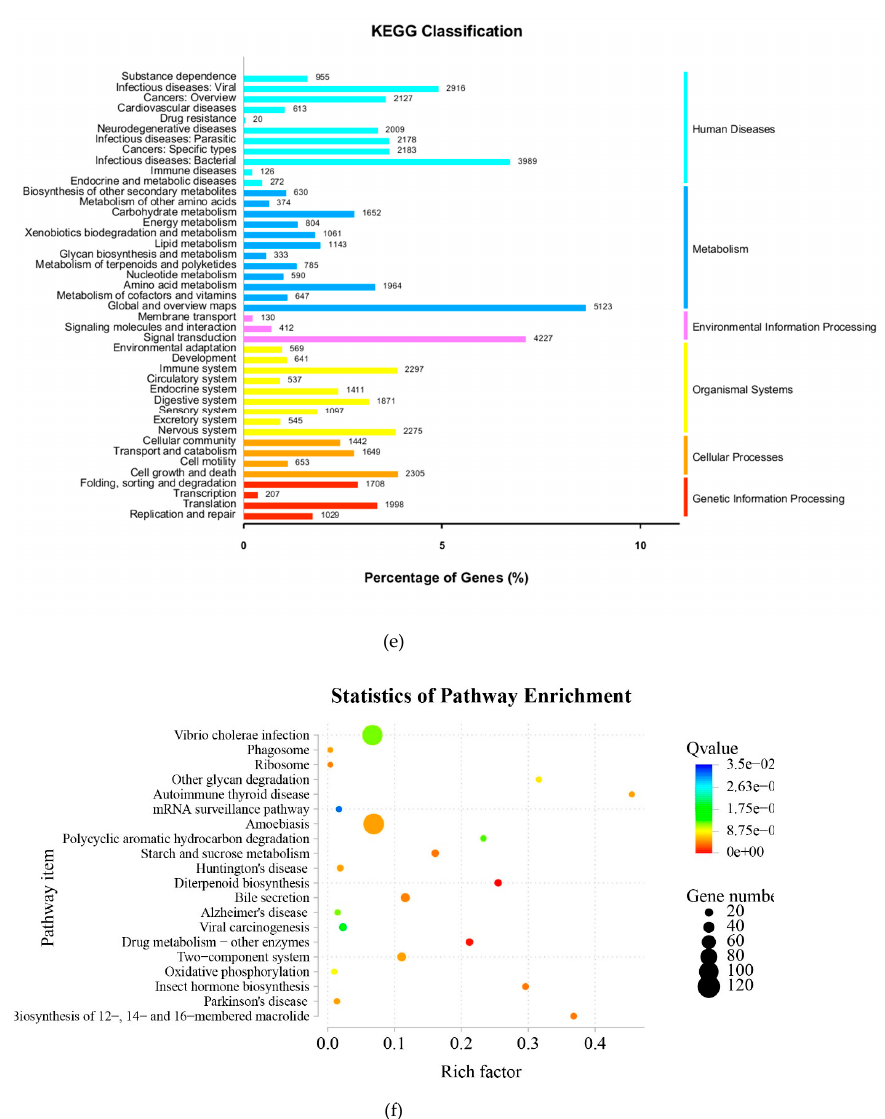
Figure 6. ( a ) Gene ontology (GO) assignment of assembled unigenes of T. mentagrophytes Functional annotation of assembled sequences based on gene ontology (GO) categorization. GO analysis was performed by Blast2Go for three main categories: cellular components, molecular function, and biological processes at the second level. The x-axis represents the GO term; the y-axis denotes the number of unigenes. ( b ) Functional annotation of DEGs (clotrimazole and control comparison) based on gene ontology (GO) categorization. GO analysis was performed for three main categories: cellular components, molecular function, and biological processes. The x-axis represents the GO term (the red and green represent all the unigenes and the DEGs annotated to the GO term respectively); the y-axis denotes the number of unigenes. ( c ) Functional annotation of DEGs (berberine and control comparison) based on gene ontology (GO) categorization. The x-axis represents the GO term (the red and green represent all the unigenes and the DEGs annotated to the GO term respectively); the y-axis denotes the number of unigenes. ( d ) Histogram of unigene KOG classification. All the unigene were searched against KOG(euKaryotic Ortholog Groups) databases using the BLASTx algorithm (E-value < 10 − 5 ). The x-axis indicates the percentage of the number of genes annotation under the group in the total number of genes annotation. The y-axis indicates the groups of KOG. ( e ) KEGG classification of unigenes. The assembled sequences were assigned to the Kyoto Encyclopedia of Genes and Genomes (KEGG) pathways (database downloaded in October 2011) using the online KEGG Automatic Annotation Server (KAAS) (http://www.genome.jp/kegg/kaas/) (BLASTx, cut-off e-value = 10 − 5 ). ( f ) Statistics of KEGG pathway enrichment. KEGG pathway enrichment were performed R